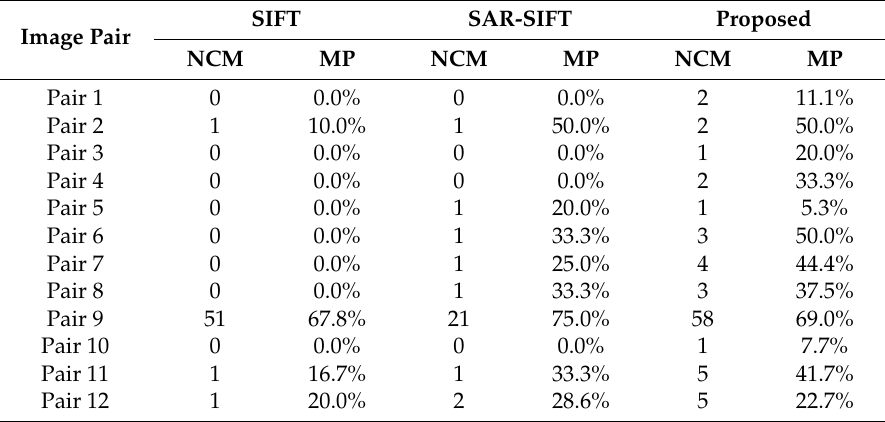
Table 6. NCM and MP values of different descriptor based matching